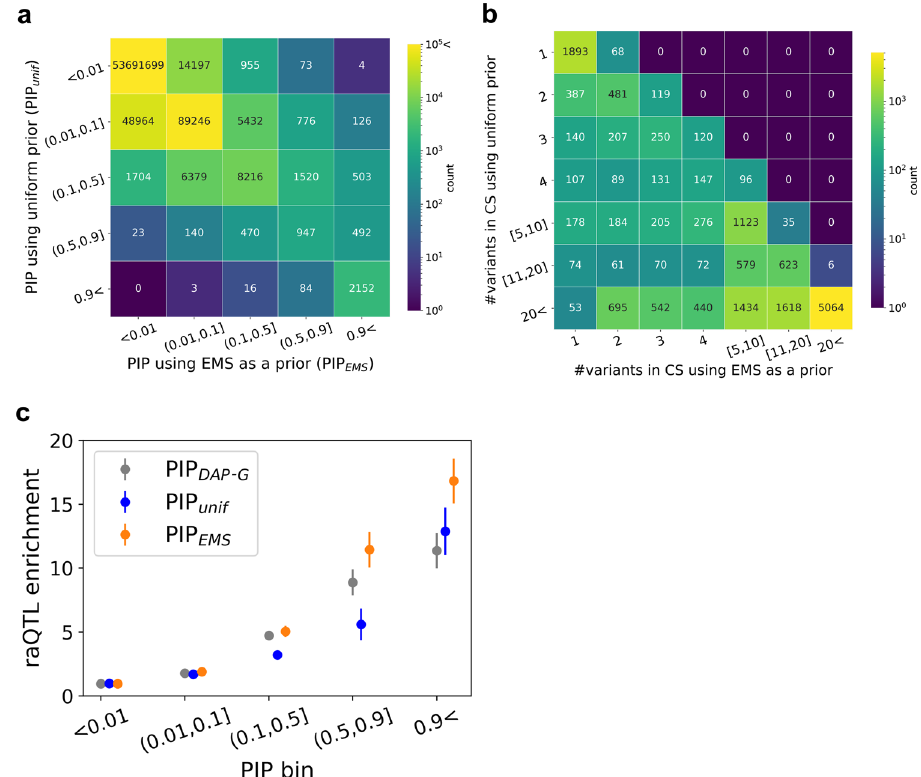
Fig. 4 Functionally informed fi ne-mapping with EMS as a prior. a Number of variant – gene pairs in different PIP bins using a uniform prior vs EMS as a prior. b Number of variants in the 95% credible set (CS) identi fi ed by fi ne-mapping with uniform prior vs EMS as a prior. c Enrichment of reporter assay QTLs (raQTLs) in different PIP bins (gray: publicly available eQTL PIP using DAP-G 23 , blue: uniform prior, orange: EMS as a prior).